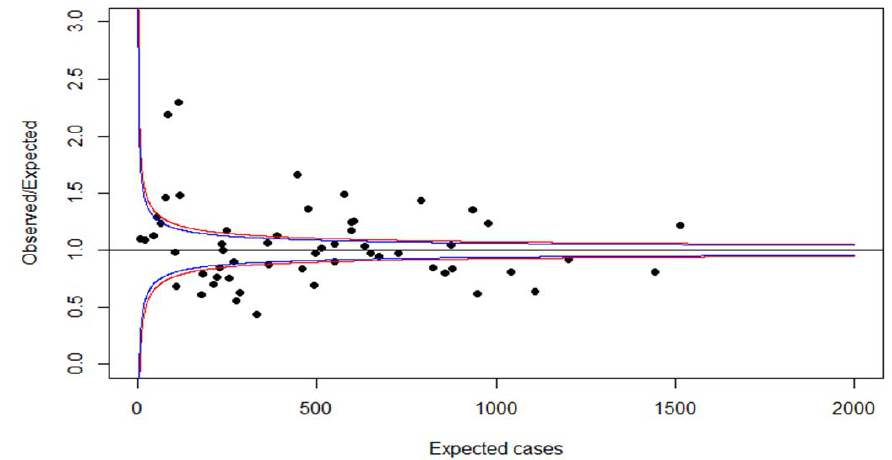
Figure 2. Standardized ratio of third level medication against expected number of third level medication in neurologists and psychiatrists in the German federal state of Saarland. Adjusted funnel plot with band limits at 95% (blue lines) and 98% (red lines).